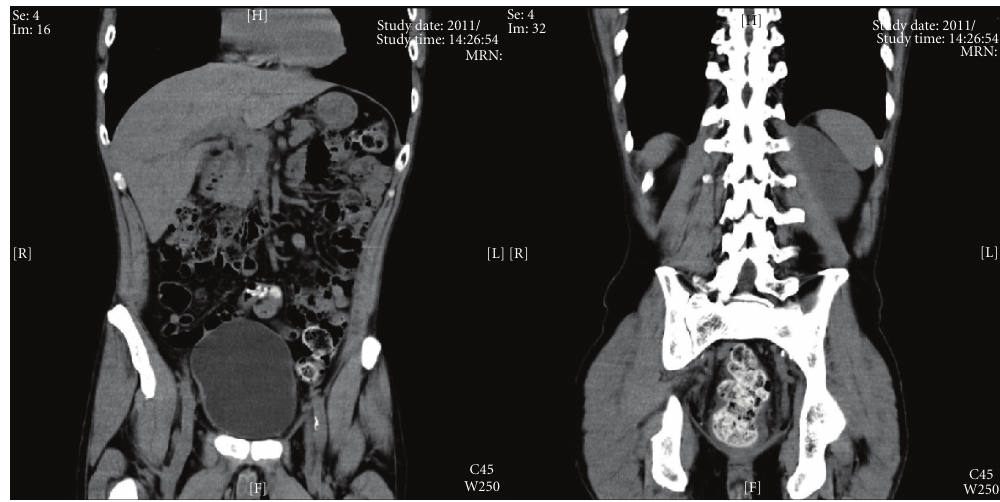
Figure 1: Coronal computed tomography scan showing the amount of colon gas and a large stool mass blocking the rectum.